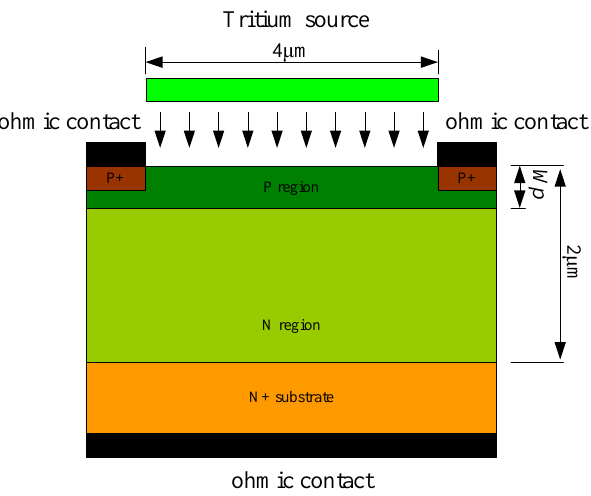
Figure 4. Structure principle diagram of SiC betavoltaic microbattery.